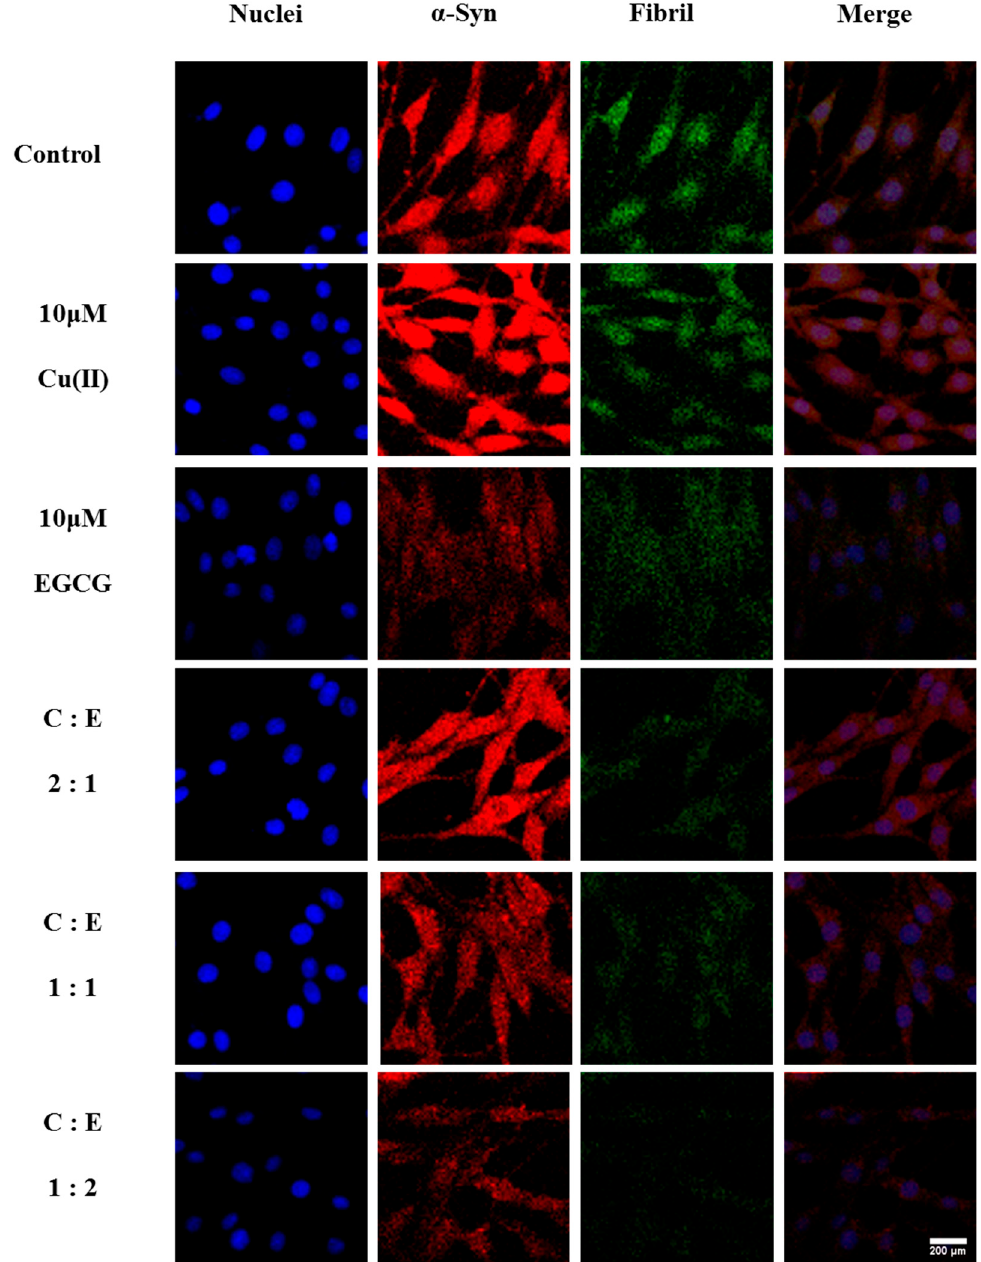
Figure 7. LSCM images of α -Syn aggregates in the transduced PC12 cells treated without and with 10 µ M Cu(II), 10 µ M EGCG, or the mixture of 10 µ M Cu(II) (symbol of C) with EGCG (symbol of E) in ratio of Cu(II) / EGCG (C:E) as 2:1, 1:1, and 1:2 for 48 h, respectively. α -Syn in the red, α -Syn fibrils in the ThT green, and the cell nuclei in the DAPI blue. Scale bars = 200 µ m. The pictures shown are representative of three individual experiments.